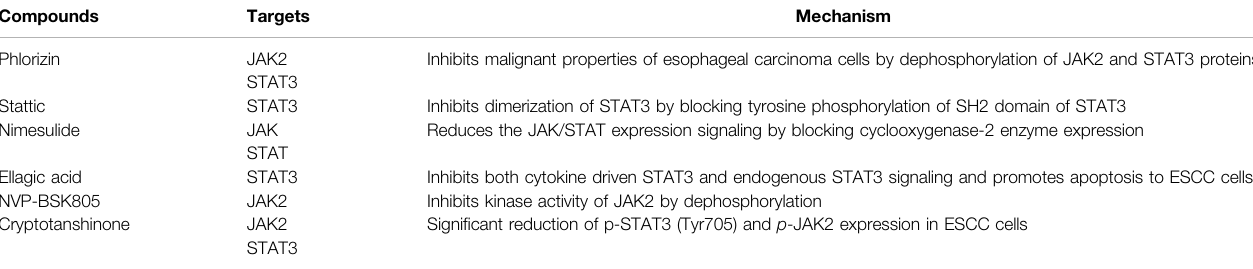
TABLE 3 | JAK/STAT signaling modulators, their targets, and mechanism in esophageal carcinoma/cells.